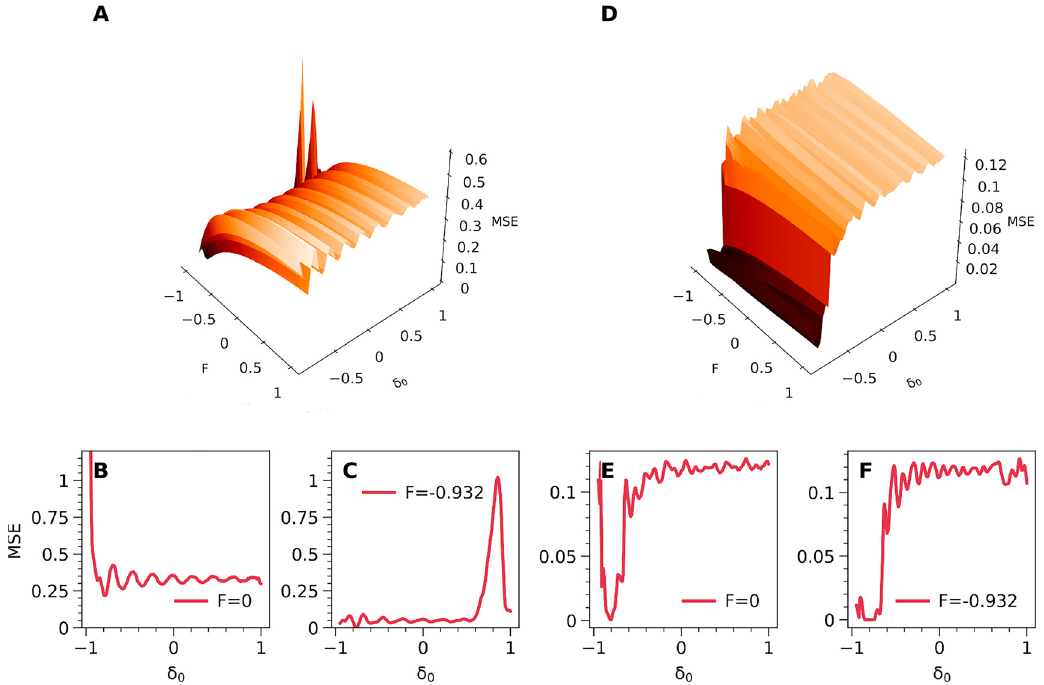
Figure 3: Finding the global minimum in an oscillatory loss landscape. (A) Mean squared error (MSE) between the desired and predicted transmissions in function of F and δ 0 . The desired transmission is an example T ( λ ) from the test set. The loss function shows many local minima. (B) Cross-section of the MSE on the transmissions as a function of δ 0 for F = 0. (C) Cross-section of the MSE as a function of δ 0 for F = 0.932. (D) MSE between the Fourier power spectra of the desired and predicted transmissions versus F and δ 0 . Note the different scale on the y -axis with respect to (A – C). (E) Cross-section of the MSE on the Fourier spectra as a function of δ 0 for F = 0. (F) Cross-section of the MSE on the Fourier spectra as a function of δ 0 for F = −